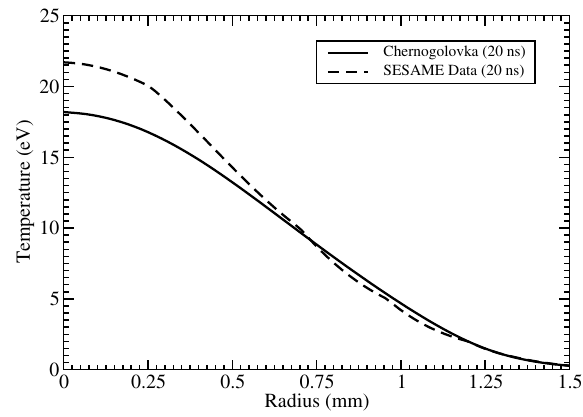
FIG. 19. Density vs radius at t (cid:3) 170 ns for the calculations presented in Fig.